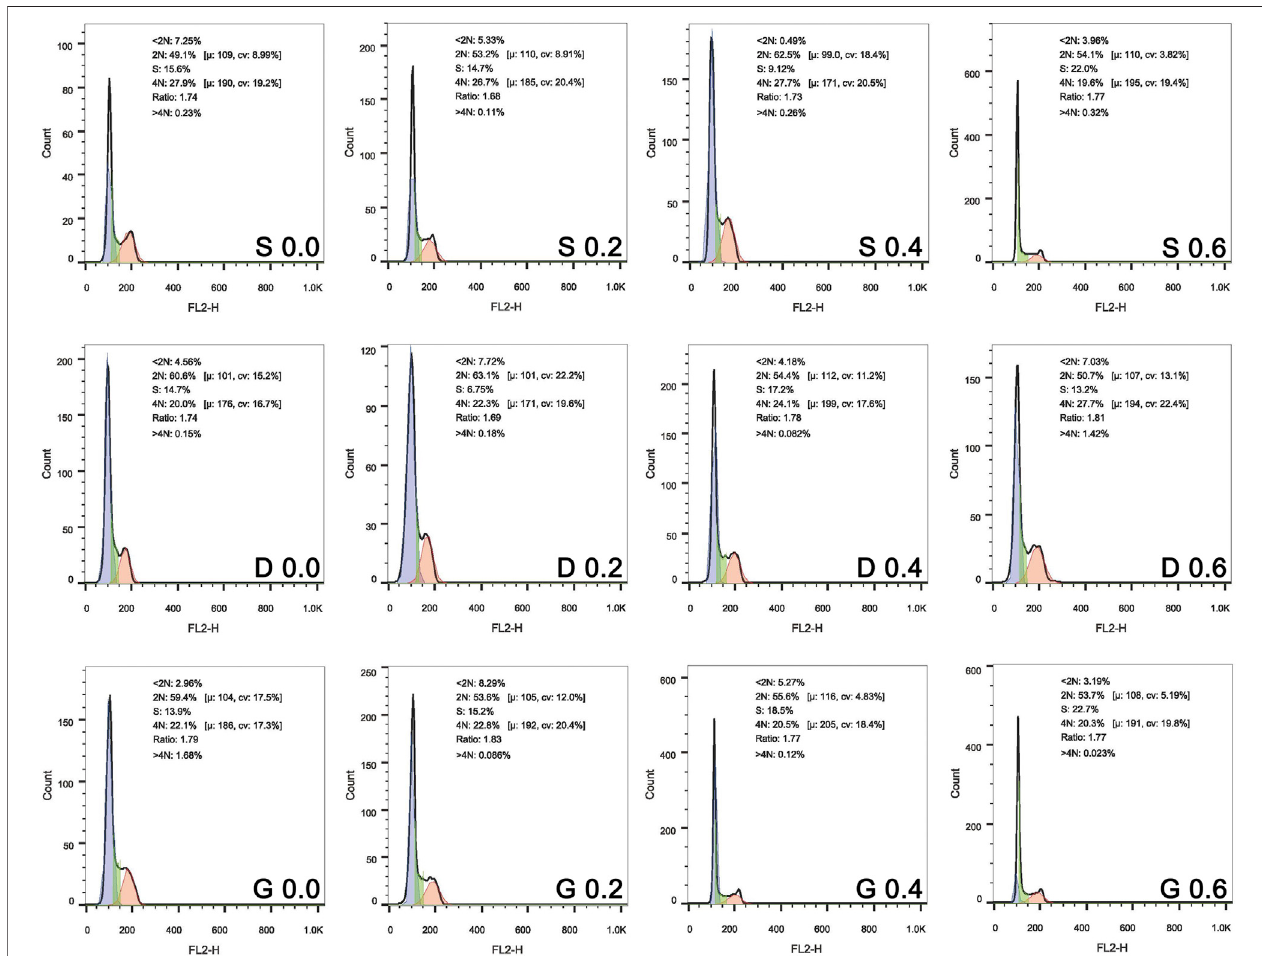
FIGURE 10 | Cell cycle of rMSCs on scaffolds with varied TPMS architectures after 1 day of co-culture.